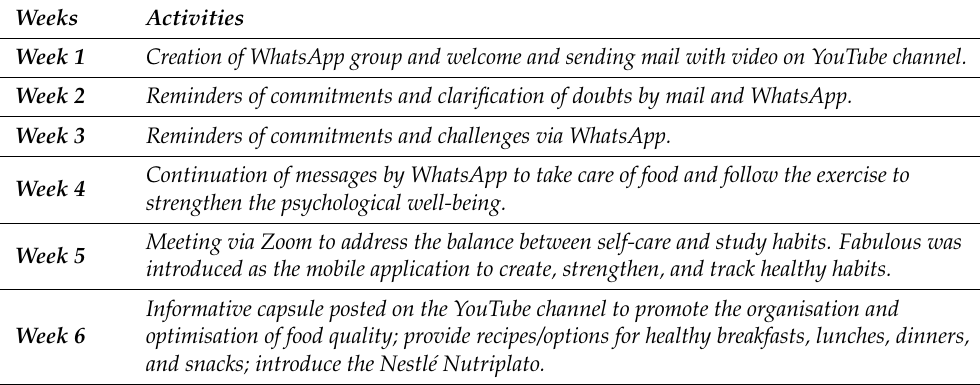
Table 2. Activities carried out during the 12 weeks of the ePSICONUT